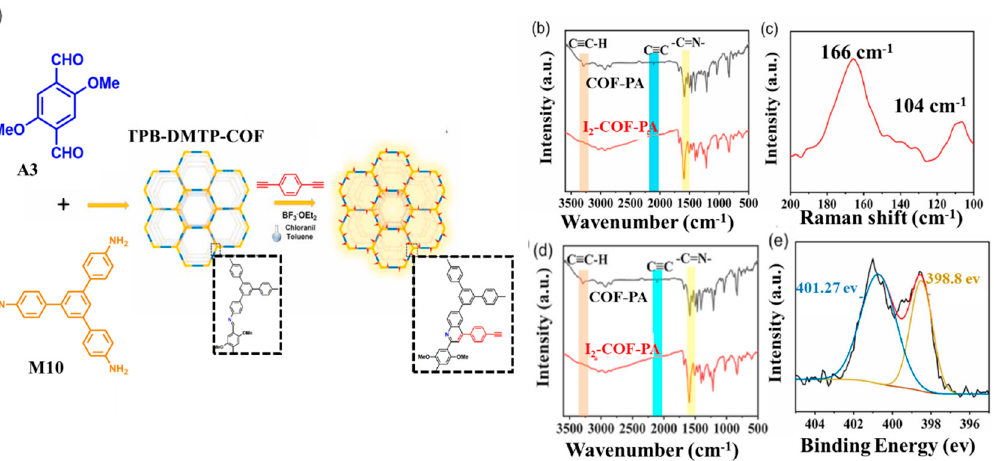
Figure 2. ( a ) Synthetic route. ( b ) FT-IR spectra. ( c ) Raman spectra of I2@COF-PA. ( d ) FT-IR spectra of COF-PA and I 2 @COF-PA. ( e ) XPS survey spectrum. Reprinted/adapted with permission from Ref. [54]. Copyright (2021), Elsevier.